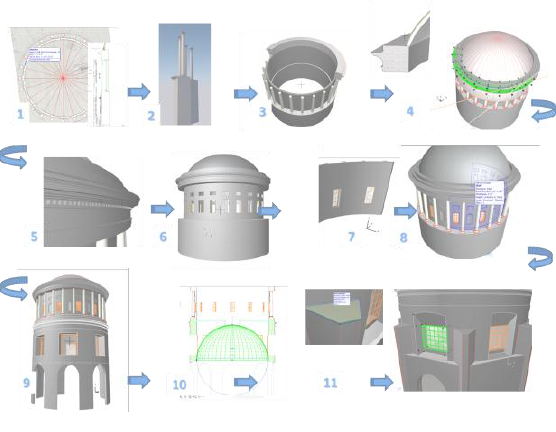
Figure 4: Details 1 to 11 - Historic Model